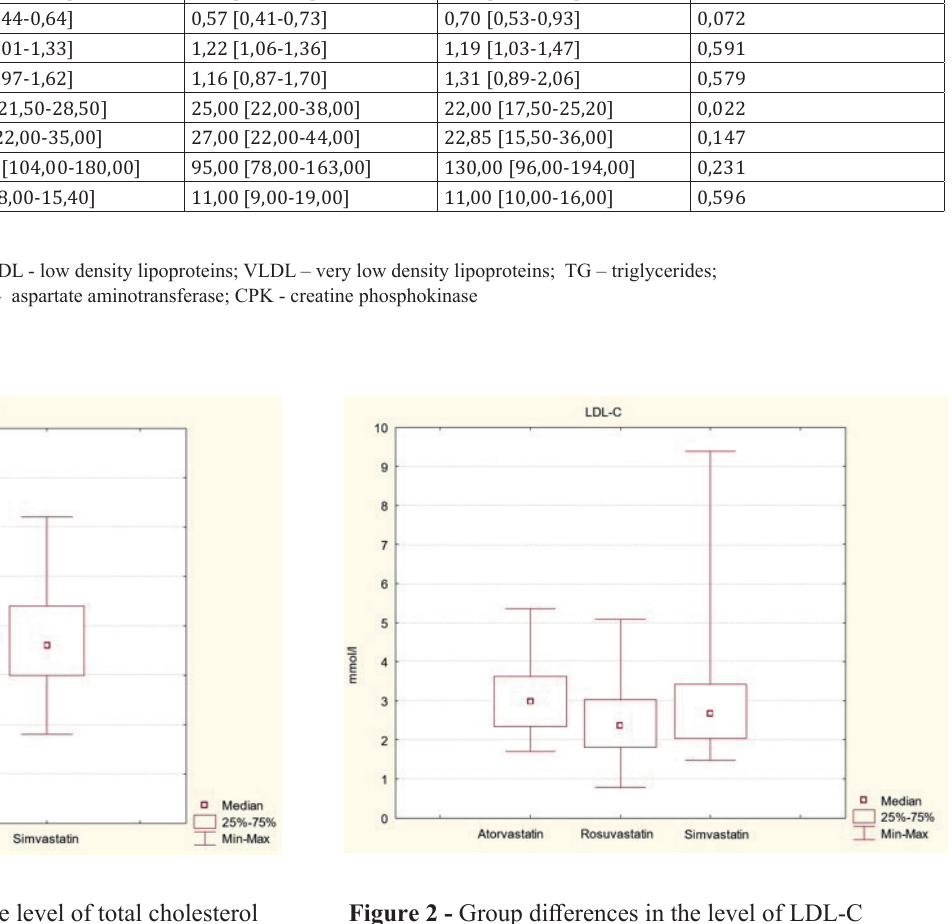
Figure 2 - Group differences in the level of LDL-C depending on the choice of